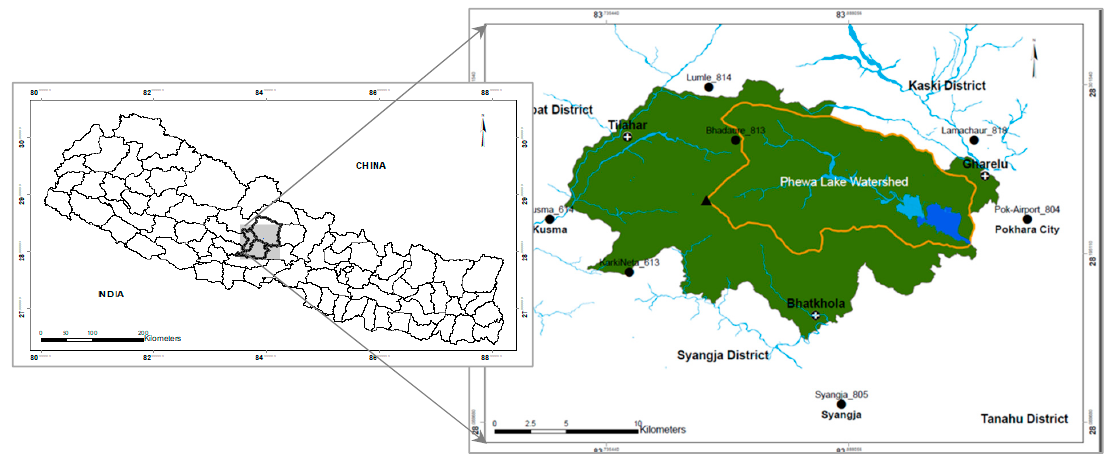
Figure 1. Location of Panchase geographic region in Central–Western hills of Nepal.